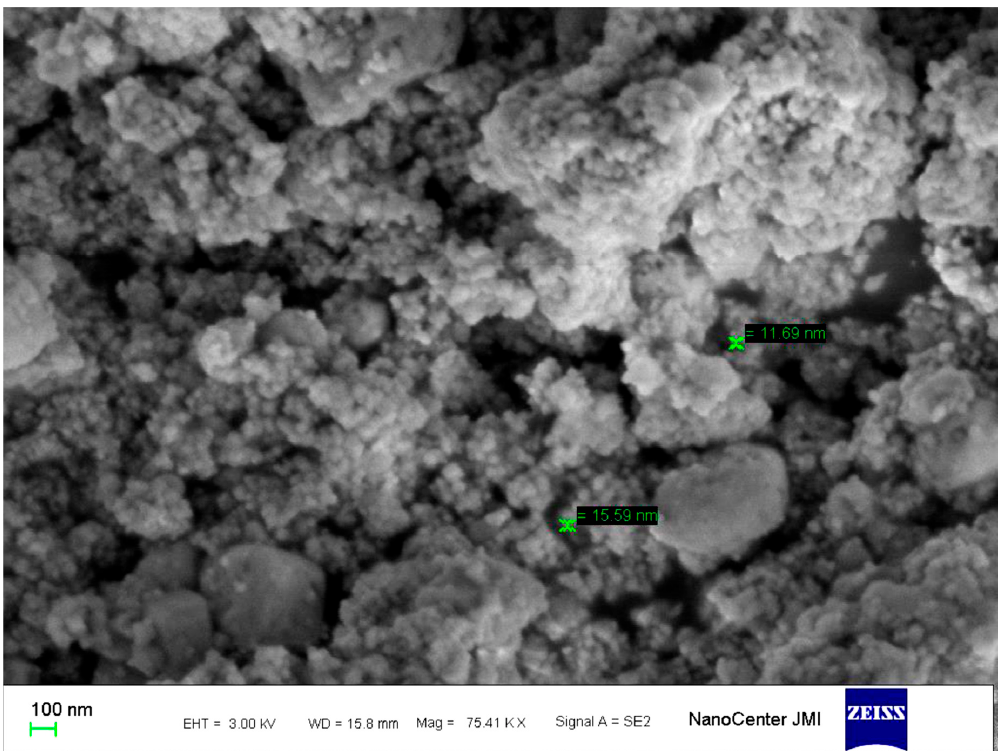
Figure 3. Scanning electron microscopy (SEM) image of biosynthesized AgNPs using Citrobacter spp. MS5 culture supernatant and AgNO 3 (1 mM) solution.